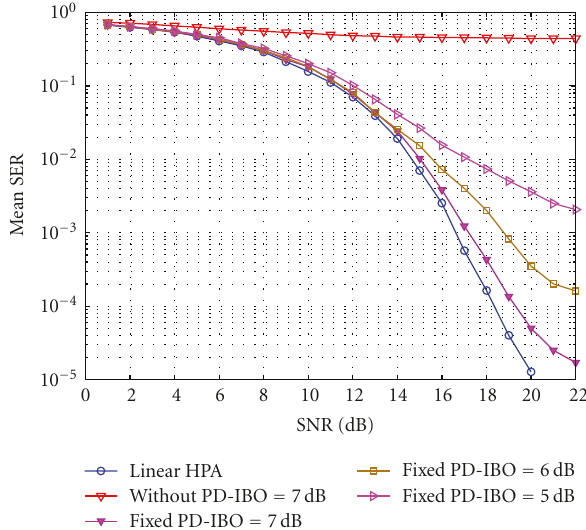
Figure 14: SER performance of PD in OFDM system, with time- invariant TWTA.